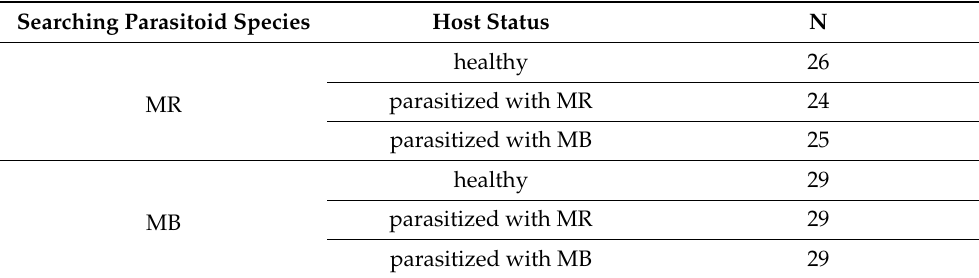
Table 2. Summary of the treatments for testing host orientation in Mallophora ruficauda and M. bigoti to previously parasitized Cyclocephala signaticollis with conspecifics or heterospecifics. MR: M. ruficauda ; MB: M. bigoti . Searching Parasitoid